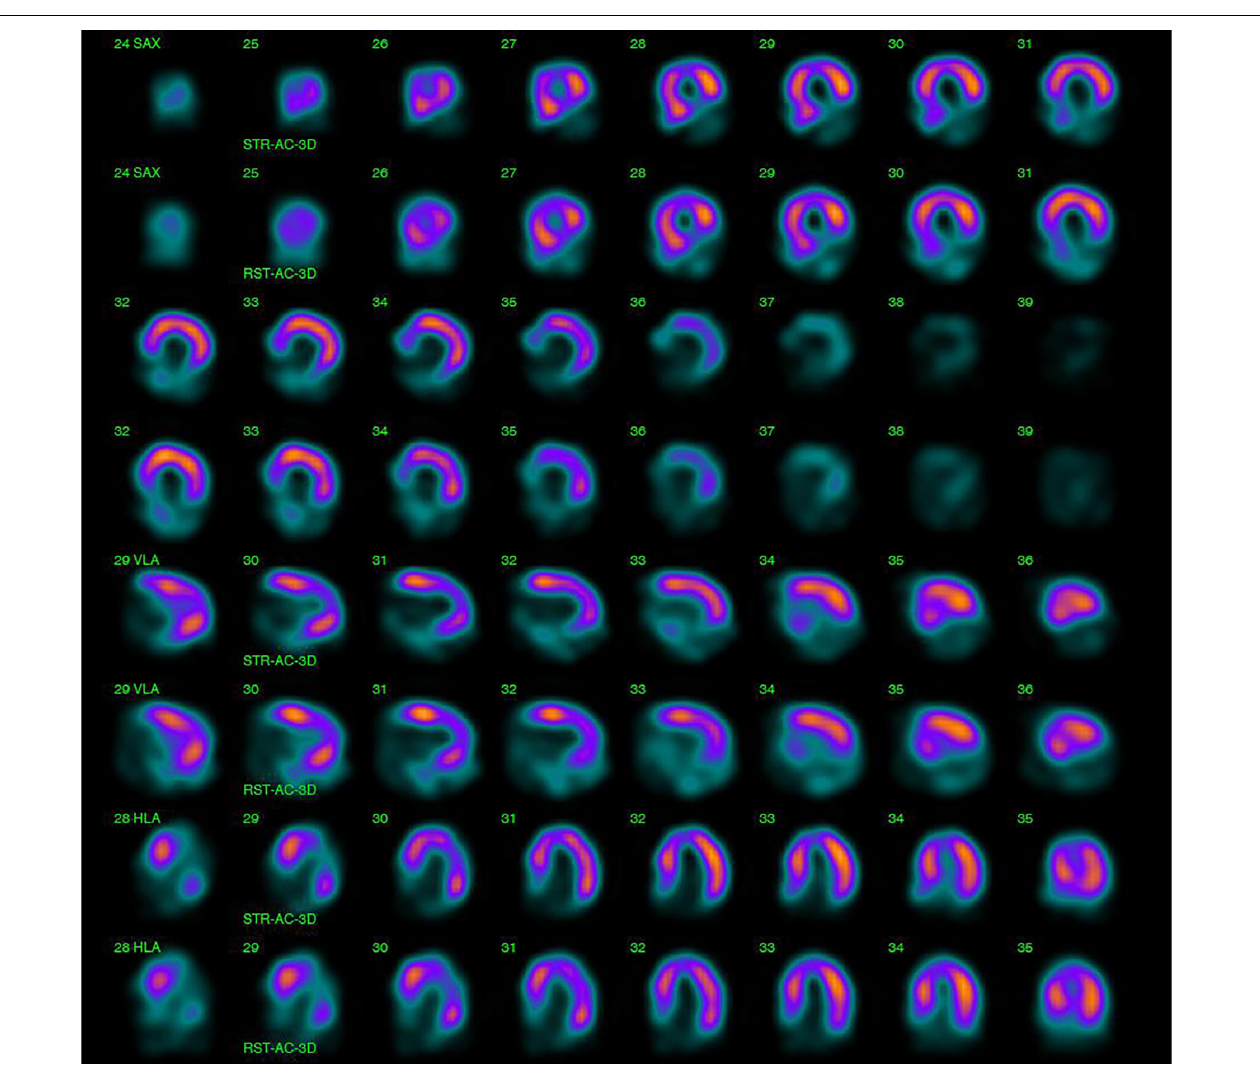
FIGURE 6 | Single-photon emission computed tomography (SPECT) for the assessment of myocardial ischemia and viability. 47-year-old male with a history of Hodgkin lymphoma, treated with radiotherapy and chemotherapy, was diagnosed with regional wall motion abnormalities in the inferior left ventricular wall during regular echocardiographic surveillance and was referred for SPECT. A fixed perfusion defect in the basal and mid inferoseptal, inferior and inferolateral left ventricular segments was found on SPECT with a summed stress and rest score equal to 16 (summed difference score 0). Findings were consisted with a silent myocardial infarction, characterized by non-viable myocardium in the right coronary artery perfusion